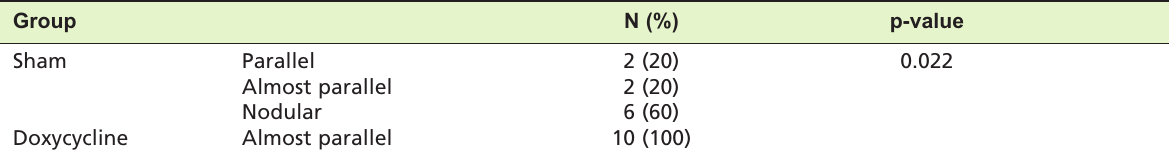
Collagen deposition condition Table I: